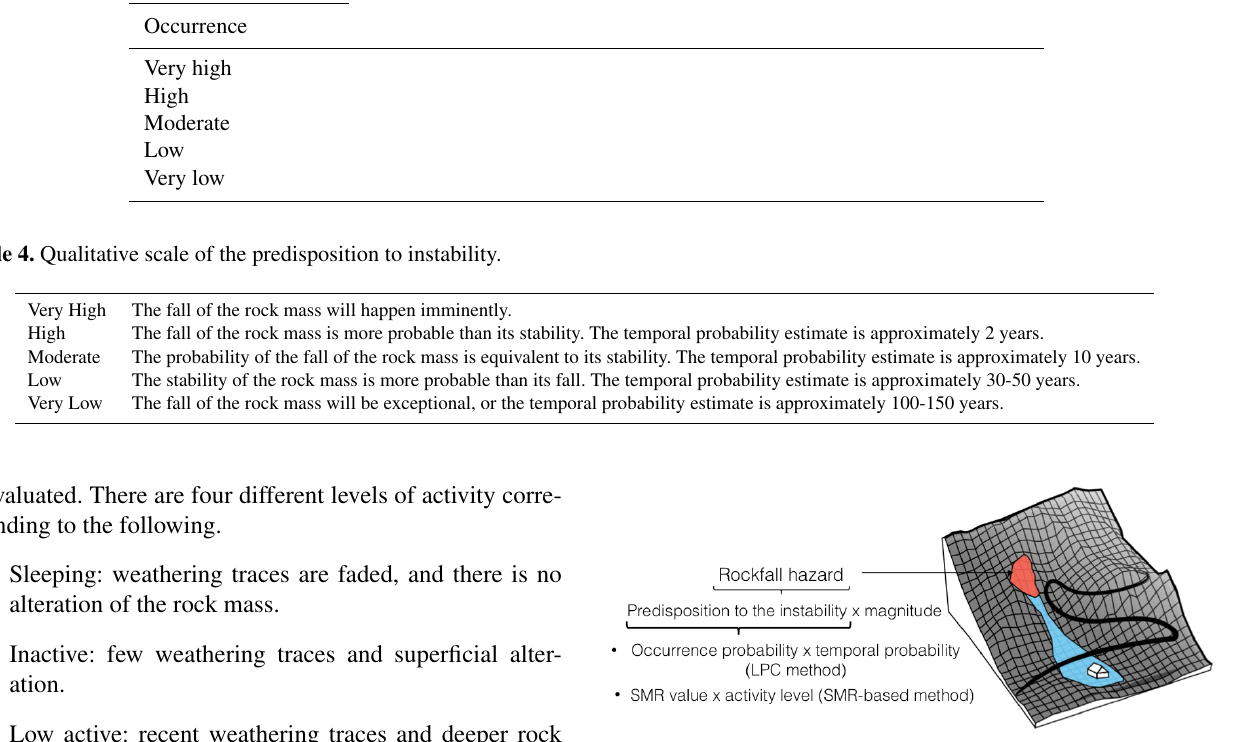
Figure 4. Terms considered in the LPC and SMR-based